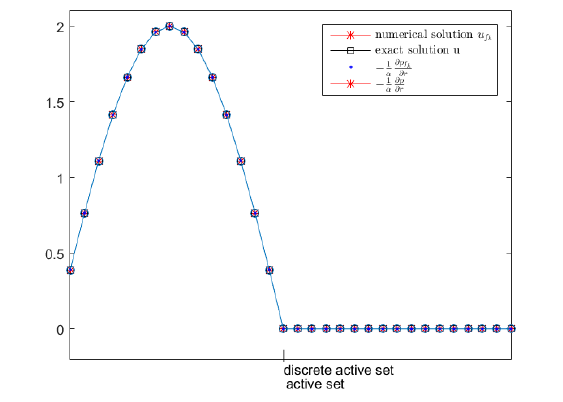
Figure 12. Discrete active set and active set of Dirichlet boundary control u